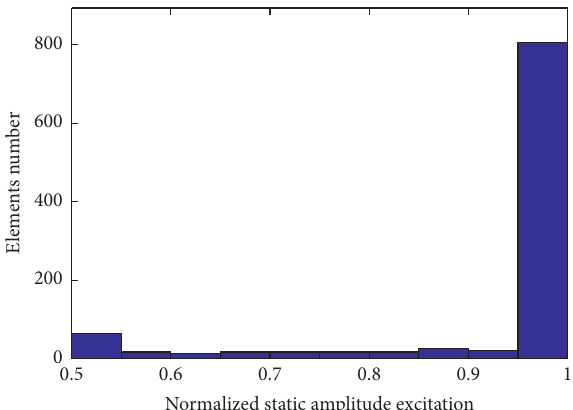
Figure 7: Normalized static amplitude excitation